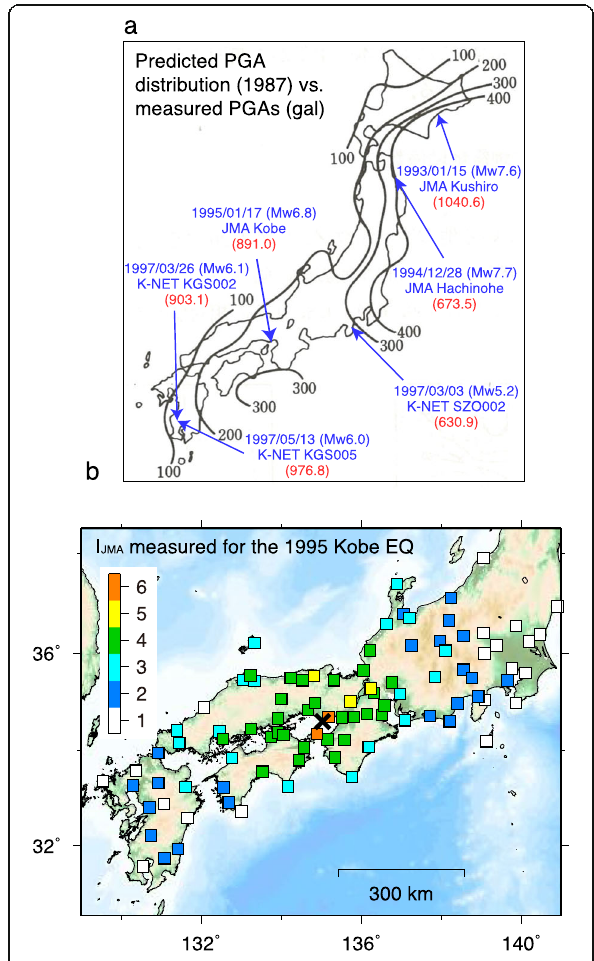
Fig. 4 Comparison of predicted seismic risk and